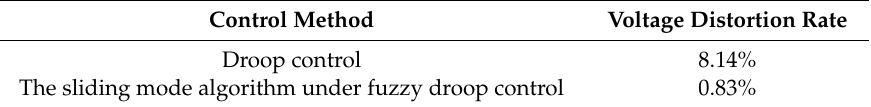
Figure 13. The voltage waveform of the fuzzy droop control strategy under sliding mode control.